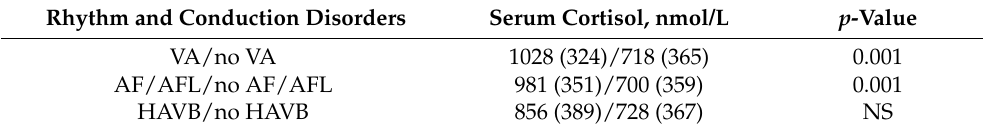
Table 3. Serum cortisol level association with the rhythm and conduction disorders.